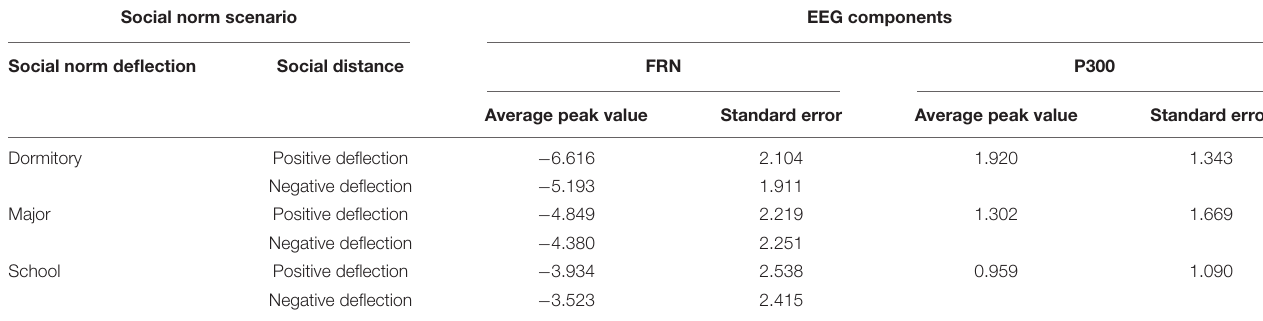
TABLE 2 | The average peak value and standard error of FRN and P300 in different social distance